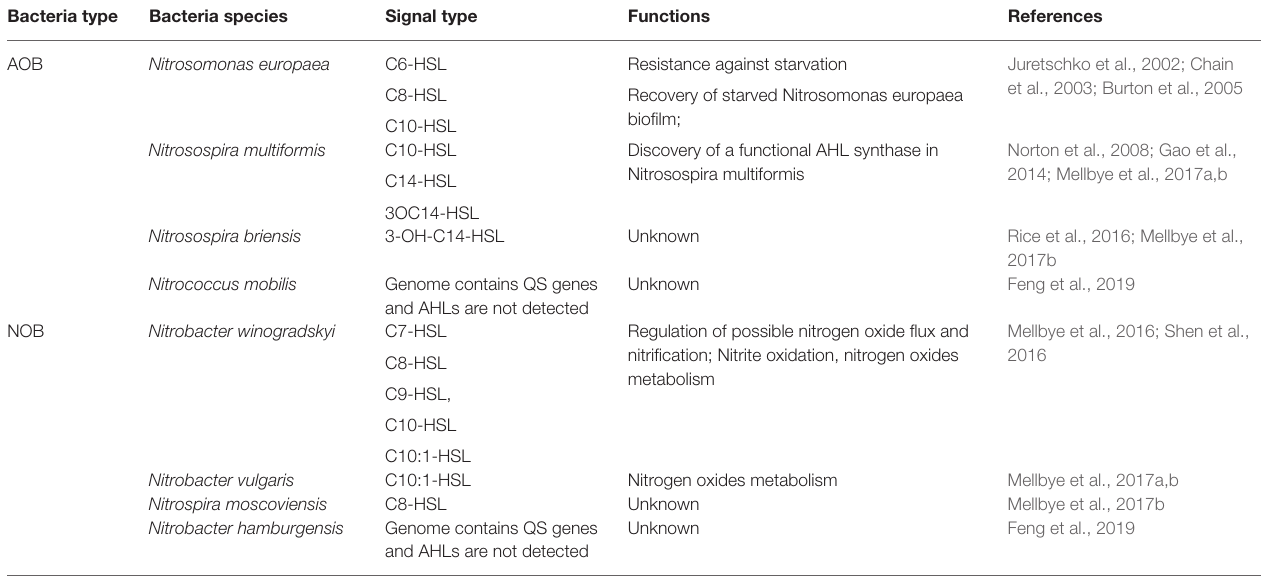
TABLE 1 | QS systems related to partial